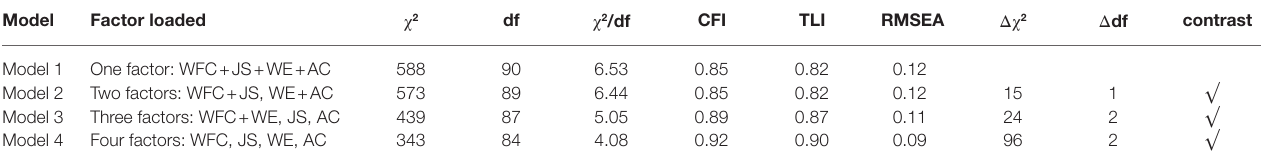
TABLE 1 | Confirmatory factor analysis to assess construct validity.